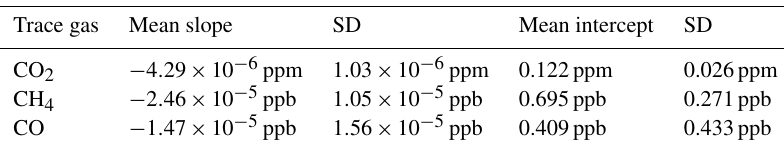
Figure 3. Results of the inlet pressure sensitivity tests for CO 2 , CH 4 and CO, using OV as an independent variable. For each test, “d” denotes the difference with respect to the mean raw mole fraction measured during the whole test. Table 5. Mean slope and intercept for the fits (Fig. 3) associated with each trace gas (as well as the associated standard deviations, SDs) in the inlet pressure sensitivity